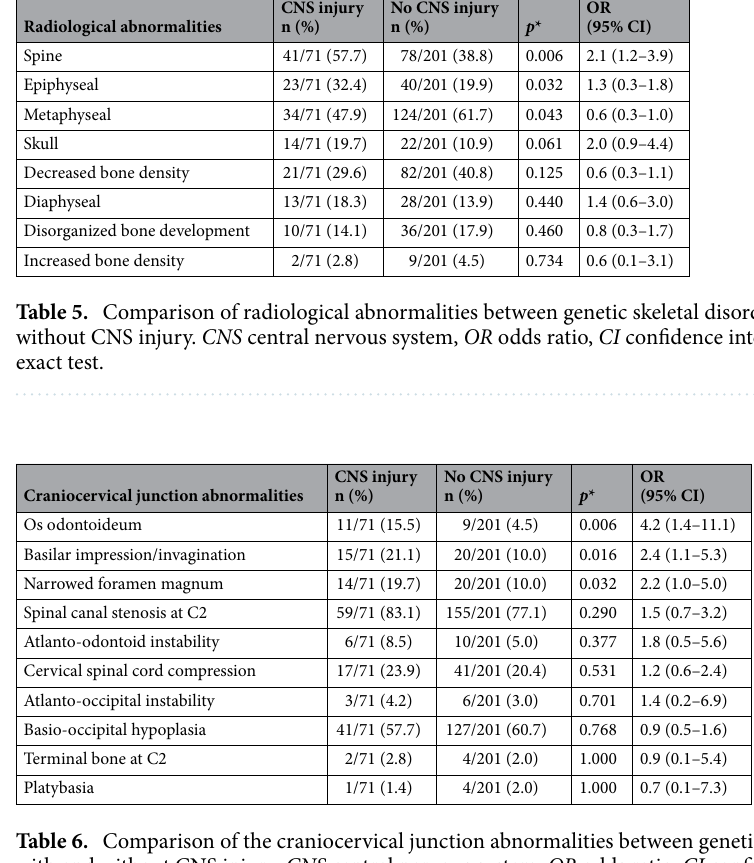
Table 6. Comparison of the craniocervical junction abnormalities between genetic skeletal disorder patients with and without CNS injury. CNS central nervous system, OR odds ratio, CI confidence interval. *X 2 test or Fisher’s exact